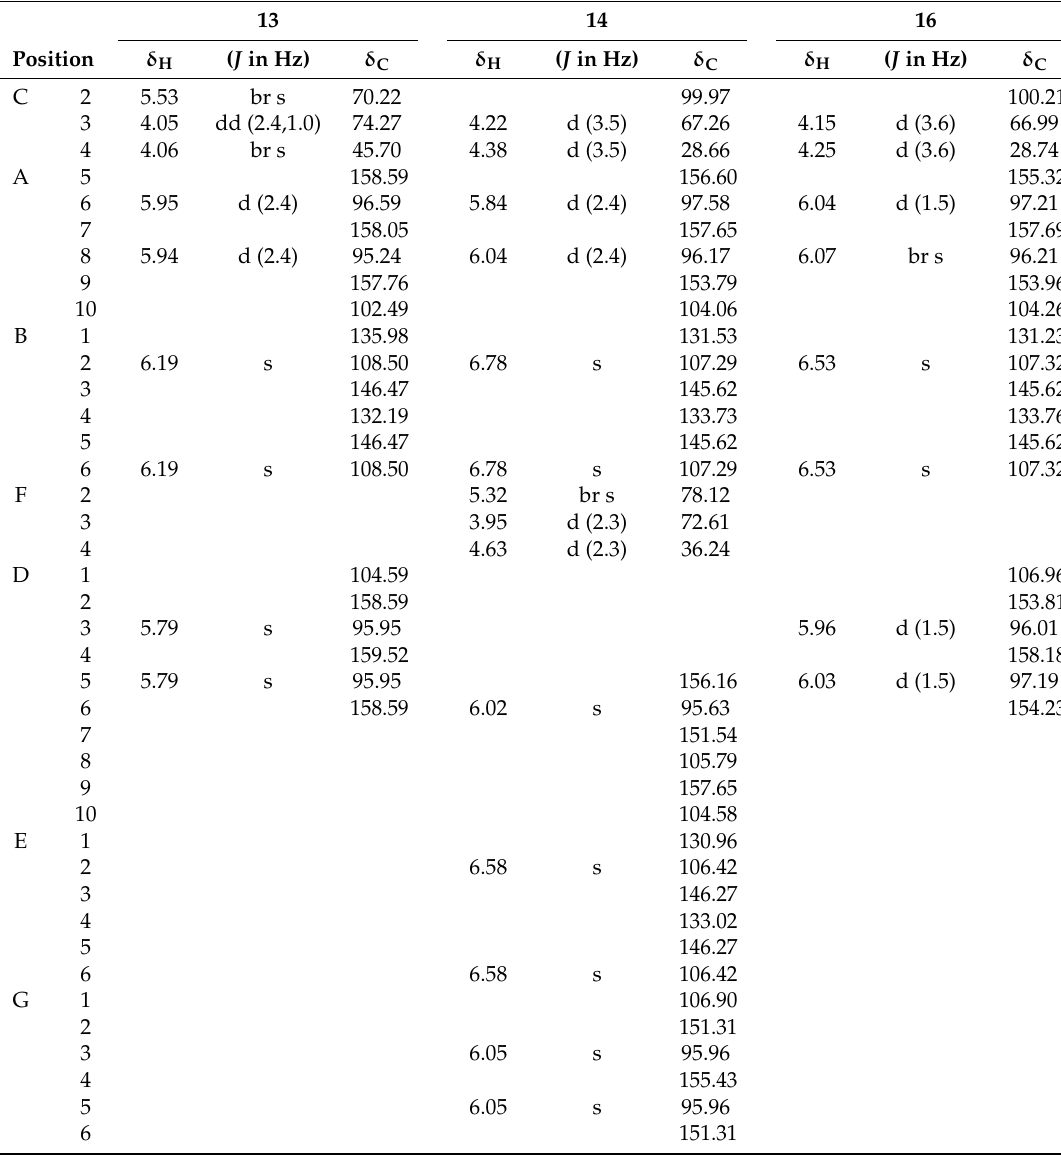
Table 2. 1 H- (500 MHz) and 13 C- (125 MHz) NMR data of 13 in methanol- d 4 , 14 and 16 in acetone- d 6